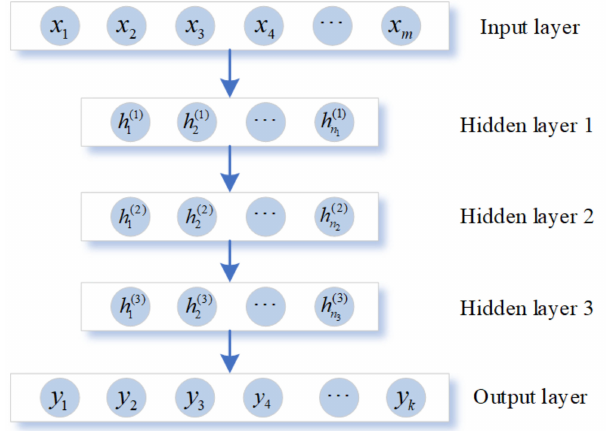
Figure 2. The structure diagram of SSAE